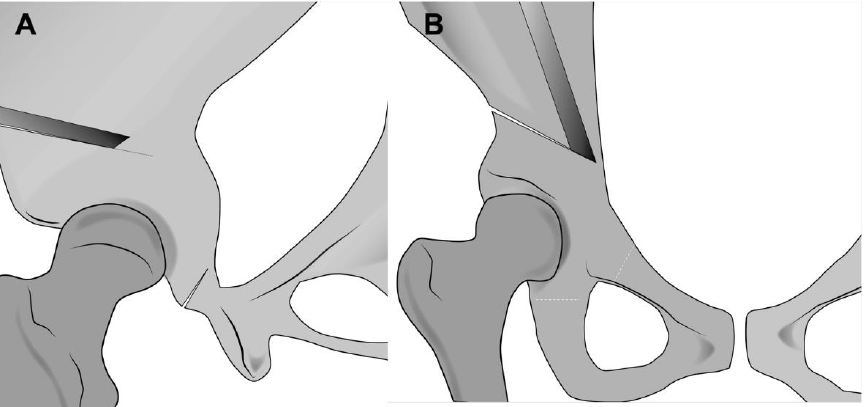
Figure 8. ( A ) Illustration depicting supraacetabular osteotomy that is directed towards the greater sciatic notch, ending 1 cm before the pelvic brim. ( B ) Retrotrochanteric osteotomy is commenced by angulating an osteotome towards the ischium, cutting through the thick bone of the pelvic brim into the posterior column.